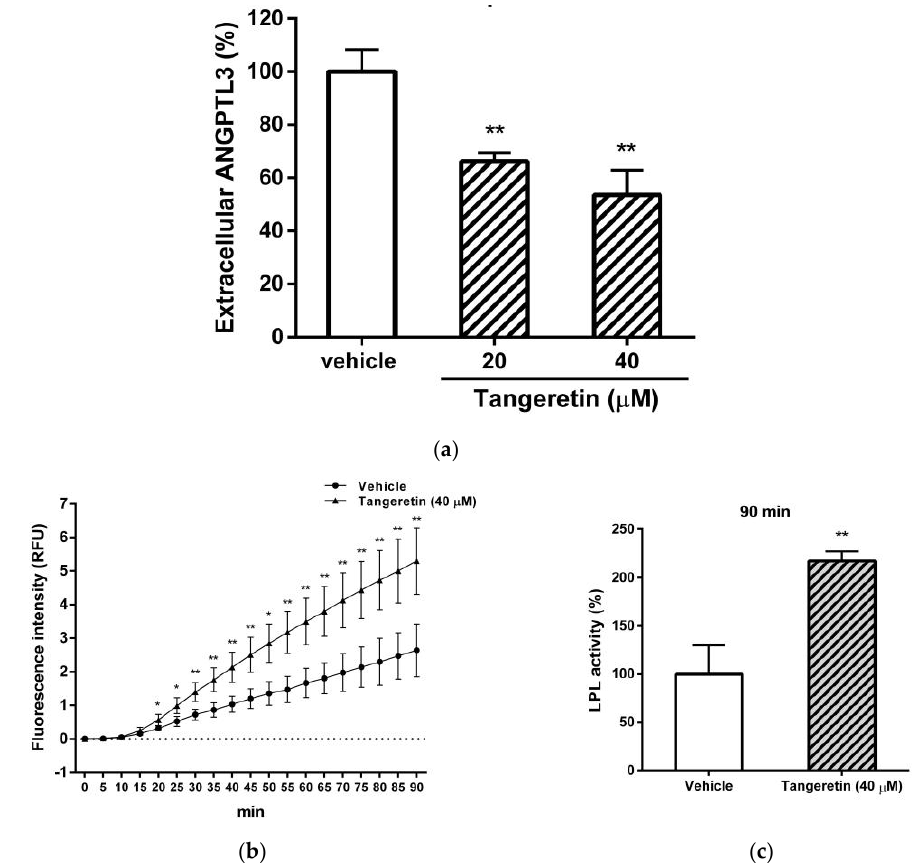
Figure 5. The effect of the tangeretin-mediated reduction of ANGPTL3 on LPL activity. HepG2 cells were treated with vehicle (0.1% DMSO) or tangeretin (20 and 40 μM) for 24 h. ( a ) The culture medium was collected, and the extracellular ANGPTL3 proteins were determined by ELISA as described in the Materials and Methods. ( b ) HepG2 cells were treated with vehicle or tangeretin (40 μM) for 24 h, and extracellular protein samples were prepared as described in the Materials and Methods. The protein samples (50 μg) and LPL proteins were incubated with substrates to determine the catalytic activity of the LPL enzyme in a fluorogenic analysis. The fluorescence intensity was measured for 90 min, and the data represent the mean ± SD of three independent experiments. * p < 0.05 and ** p < 0.01 represent significant differences compared to the vehicle-treated group. ( c ) Fluorescence intensity (LPL activity) at t = 90 min relative to that of the vehicle-treated group. The data represent the mean ± SD from three independent experiments. ** p < 0.01 represents significant differences compared to the vehicle-treated group.